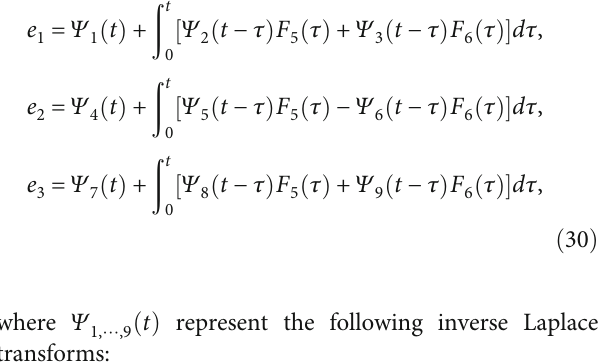
(d) errors for β = − 0 : 6 ð 0 Þ = 0 : 2 , y ð 0 Þ = 0 : 1 , z ð 0 Þ = 0 : 2 , x ð 0 Þ = 0 : 1 , y ð 0 Þ = 0 : 1 , and z ð 0 Þ = 0 : 1 1 1 2 2 1 2